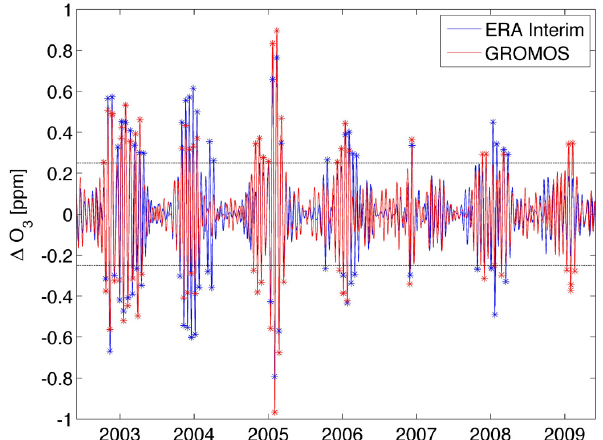
Fig. 5. Example data segment of the 20-day band-pass filtered ozone series at 7hPa from observations of the ozone microwave radiome- ter GROMOS (red line) at Bern at 46.95 ◦ N, 7.44 ◦ E is compared to ERA Interim reanalysis (blue line) at 47.5 ◦ N, 7.5 ◦ E. The timing of the extrema and the modulation of the envelope of the 20-day oscillation are in reasonable agreement. Selected extrema for the composite analysis are indicated by the blue symbols which exceed a threshold of 0.25ppm as indicated by the horizontal black